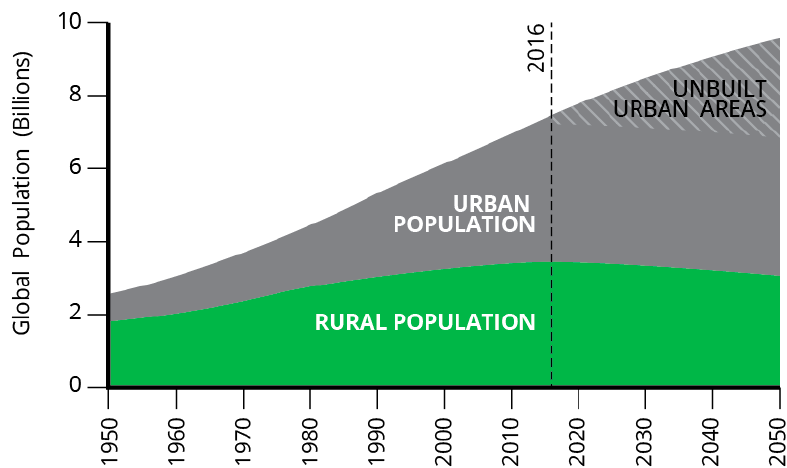
Figure 1. Urbanization population projections and unbuilt urban areas.